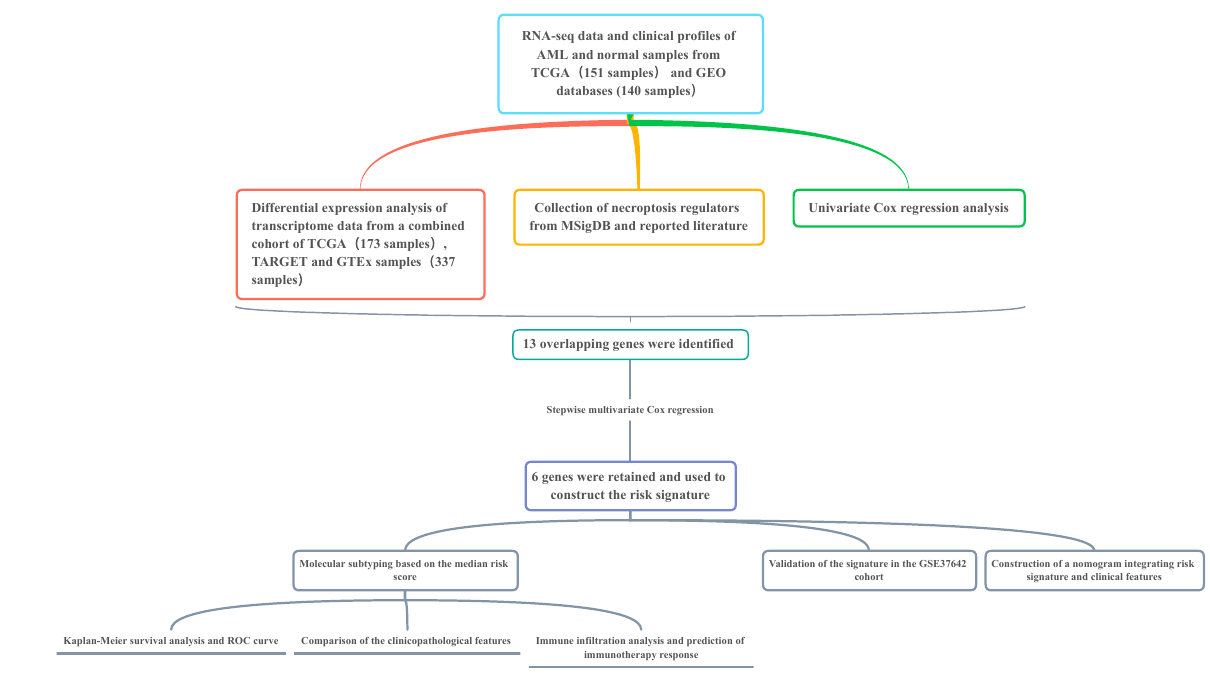
Figure 1. Overall flow chart of research design.